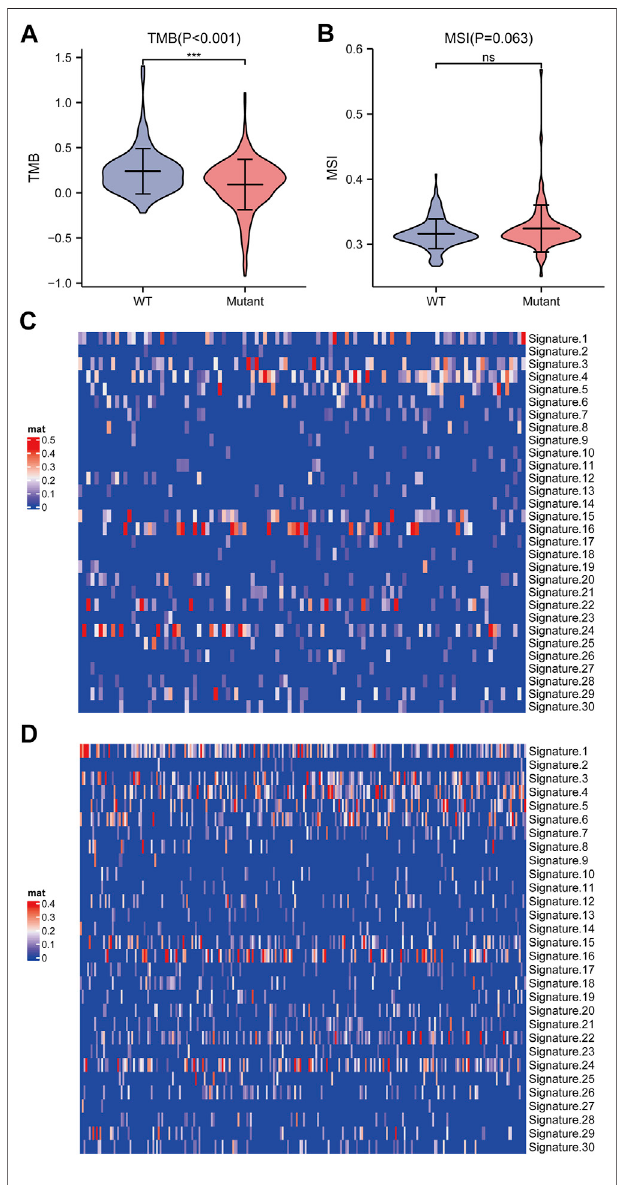
FIGURE 2 | Analysis of biological characteristics of TP53 gene mutation level. (A) : TMB in patients with TP53 mutations was signi fi cantly reduced ( p < 0.001). (B) : There is no signi fi cant difference in MSI ( p = 0.063). (C) : Cosmic Signature heat map of TP53 mutation patients. (D) : Cosmic Signature heat map of TP53 non-mutant